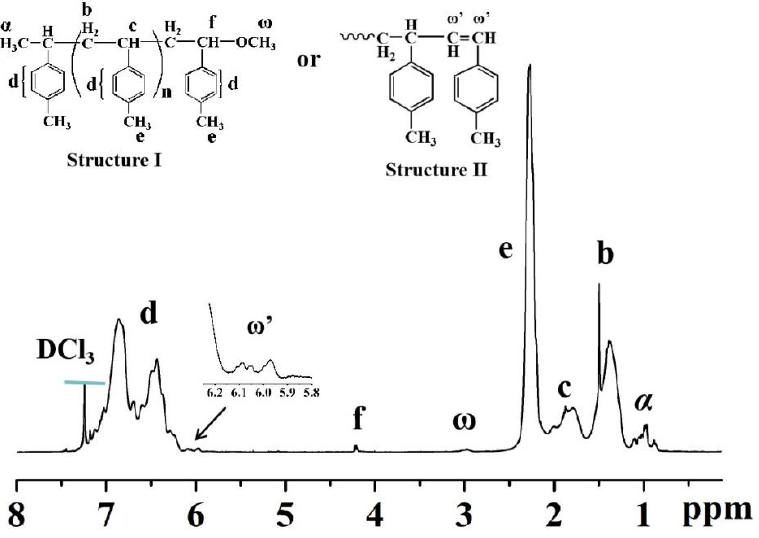
Figure 2. 1 H ‐ NMR spectrum of product polymerized in CH 2 Cl 2 .